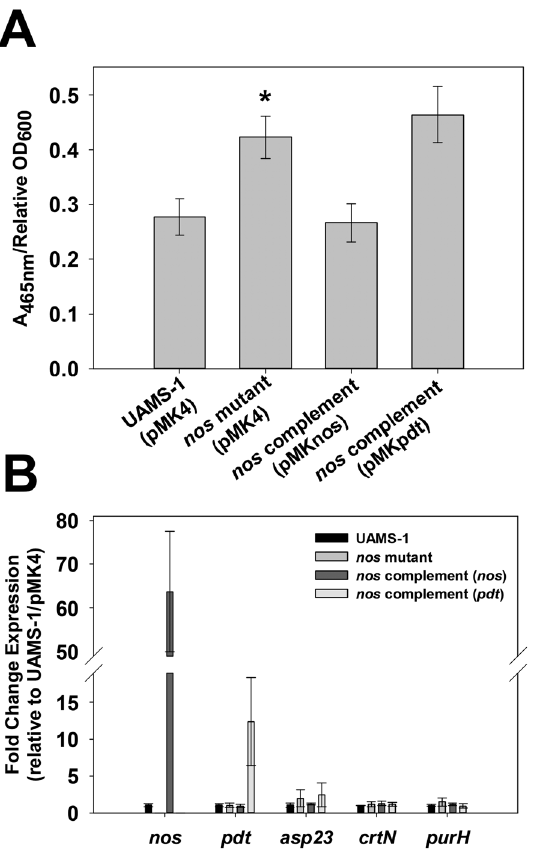
Figure 6. Effect of S. aureus nos mutation on carotenoid pigmentation. A: UAMS-1 (pMK4; wild-type), KR1010 (pMK4; nos mutant), KR1010 (pMKnos; nos complement), and KR1010 (pMKpdt; nos mutant containing pdt complement plasmid) were grown for 48 hours at 37 u C on TSA plates. Pigments from each culture were extracted with methanol, the A 465 nm of each sample was measured, and standardized by dividing by the sample’s corresponding relative OD 600 value (measured prior to methanol extraction step). Results represent the average of n=3 independent experiments, error bars = SEM. *statistical significance compared to UAMS-1 (pMK4) (p , 0.05, Stu- dent-Newman-Keuls Test). B: Total RNA from 28 hour TSA plate cultures of UAMS-1 (pMK4), nos :: erm mutant (pMK4), nos complement and pdt complement strains (n=3 biological replicates each) was reversed- transcribed to cDNA, and subjected to quantitative real-time PCR using primers specific for detecting nos , pdt , asp23 , crtN , and purH expression. The Livak (2 - DD Ct ) method was used to determine relative fold change expression of each gene, using measured sigA expression as the reference gene and the UAMS-1 (pMK4) sample as the